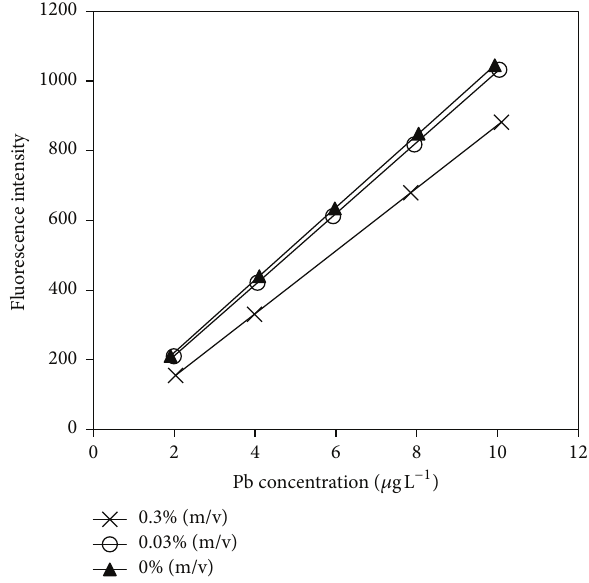
Figure 4: Calibration curves for lead obtained in the presence of different concentration of 1,10-phenanthroline. Reaction conditions: 1% (m/v) KBH 4 , 1.5% (v/v) HCl, and 1.5% (m/v) K 3 [Fe(CN) 6